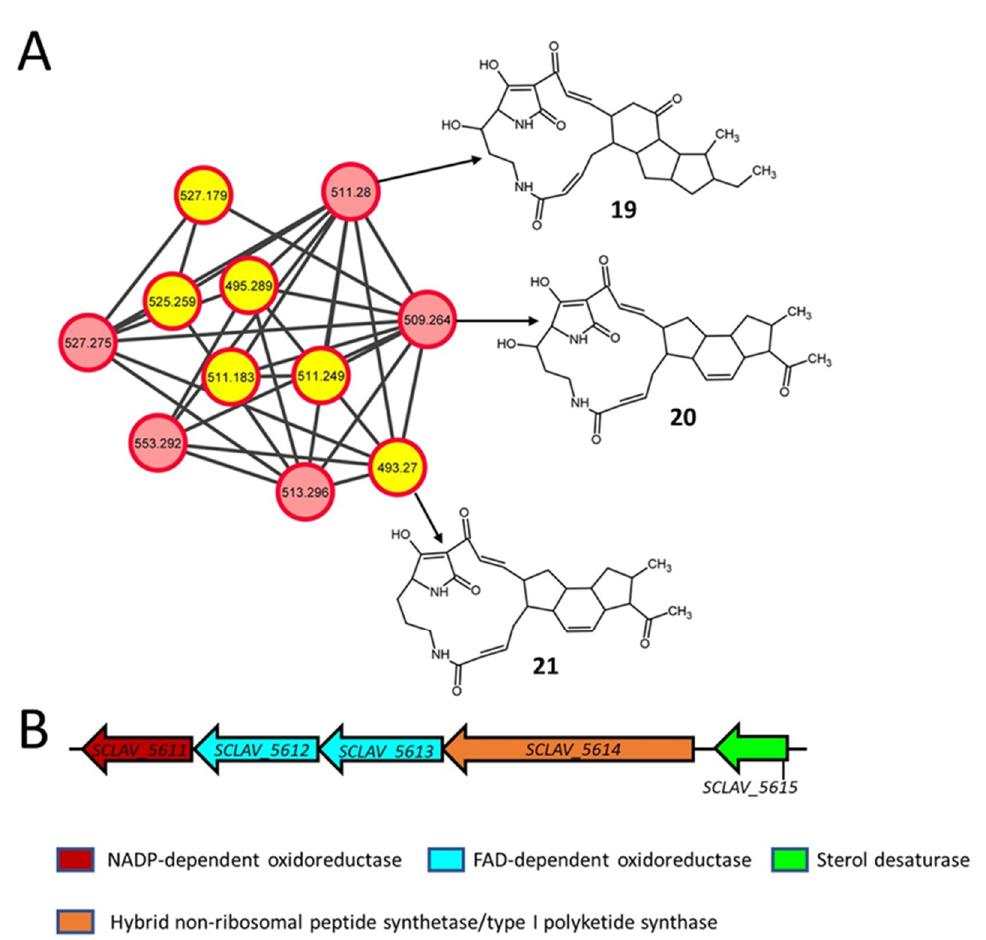
Figure 5. Molecular network (positive ionization mode) for polycyclic tetramate macrolactams (PTMs) present in different cultures from the current study and the associated biosynthetic gene cluster (BGC) in S. clavuligerus . ( A ) In silico structure prediction of the metabolites by GNPS-based molecular networking and network annotation propagation (NAP). Each node depicts a mass spectrum (labeled with m/z of the respective precursor mass) and edges represent the relationship between different nodes. The top-ranked NAP-consensus structural predictions (red boundary) for the metabolites present in all S. clavuligerus cultures, including wild-type (pink fill), and only in the different overexpression strains (yellow fill), are shown. ( B ) The proposed BGC is associated with the biosynthesis of PTMs detected in S. clavuligerus .